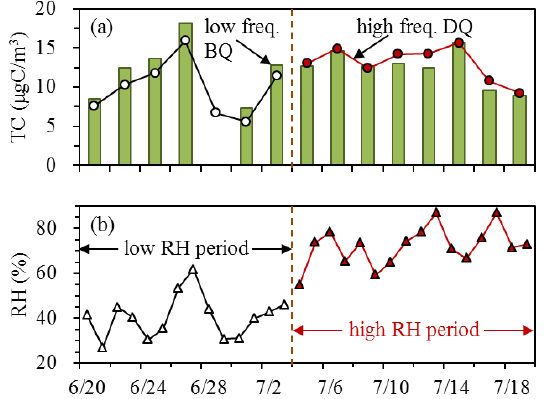
Figure 3. Temporal variations of TC concentration (48h averages) and RH (24h averages). RH averaged 41 ± 10 and 72 ± 9% during the low RH and high RH periods, respectively; the difference is significant at a 95% level of confidence (two-tailed p = 0 . 000). The identification of the high RH period is also supported by RH data from another source (i.e., the China Meteorological Data Sharing Service System; see the